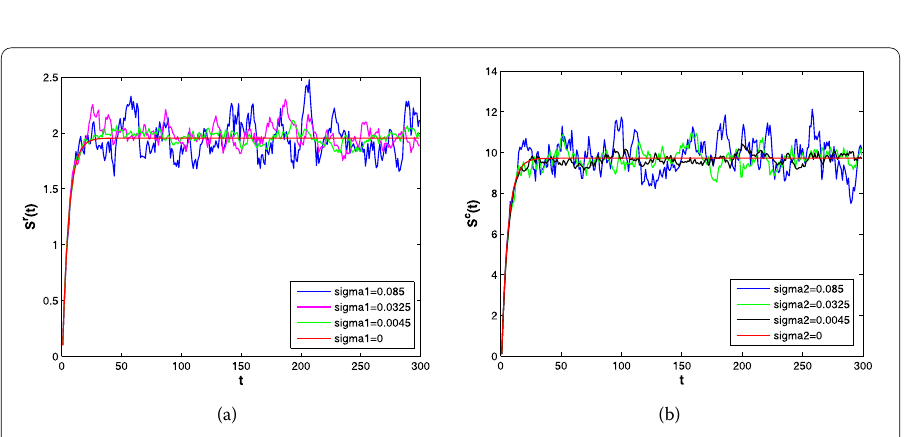
Figure 2 Trajectories ( a , b ) of the stochastic model (3) for different white noise intensity